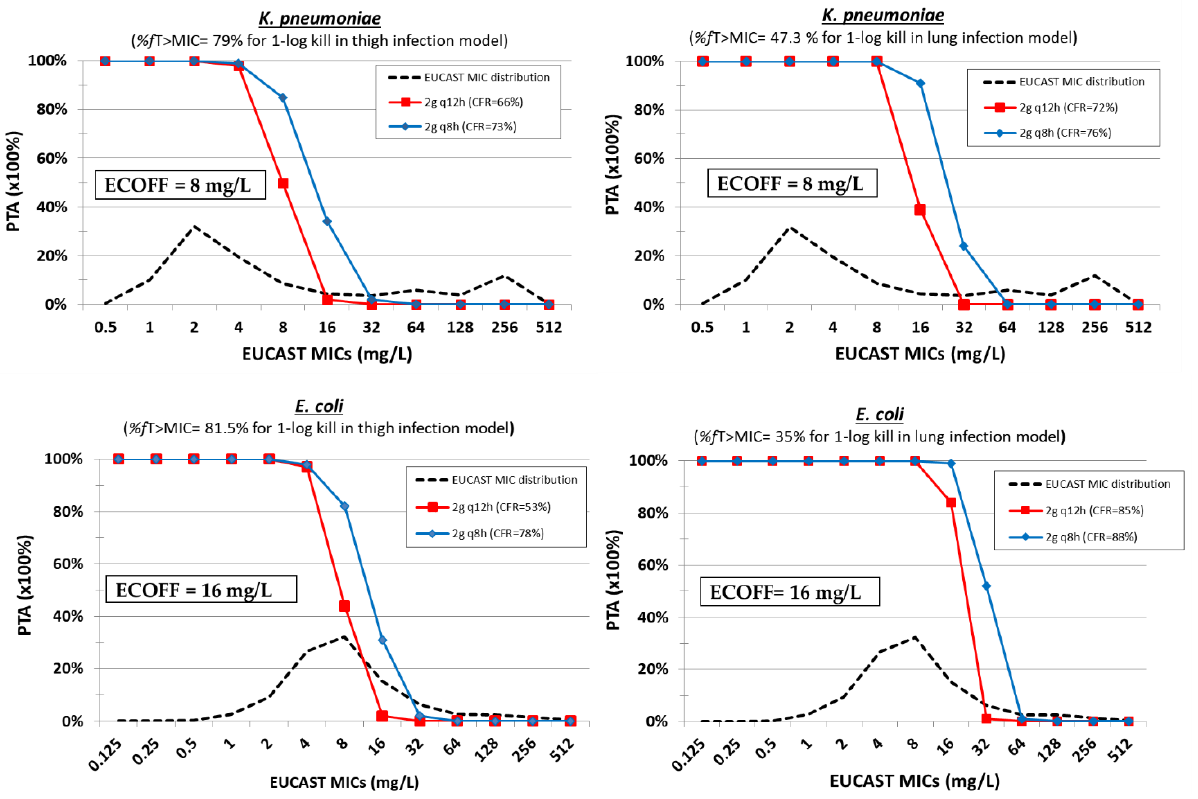
Figure 3. Probability of target attainment (PTA) of temocillin at different dosing regimens against isolates with increasing MIC. The cumulative fraction of response (CFR) is shown for a collection of isolates with the EUCAST MIC distribution.